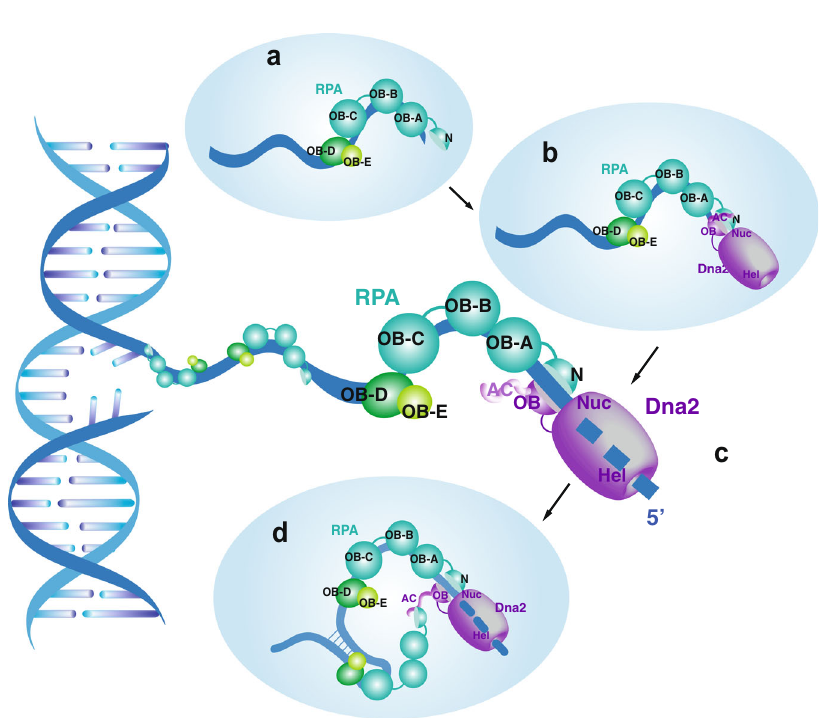
Fig. 8 A model of ssDNA digestion by the Dna2 – RPA ensemble. a RPA coats ssDNA. b RPA recruits Dna2 to the open 5 ′ -end of ssDNA. c RPA acts as a processive unit for Dna2 and delivers ssDNA for its digestion. d Dna2 trans-acts with RPA via its AC motif to overcome DNA Analysis of resection at DSB ends . Resection was analyzed at an HO endonuclease-induced nonrepairable DSB at the MAT a locus on chromosome III using Southern blots as described 10 . Brie fl y, genomic DNA was isolated by glass- bead disruption using a standard phenol-extraction method. Puri fi ed DNA was digested with Eco RI and separated on a 0.8% agarose gel. Southern blotting and hybridization with radiolabeled DNA probes was performed as described